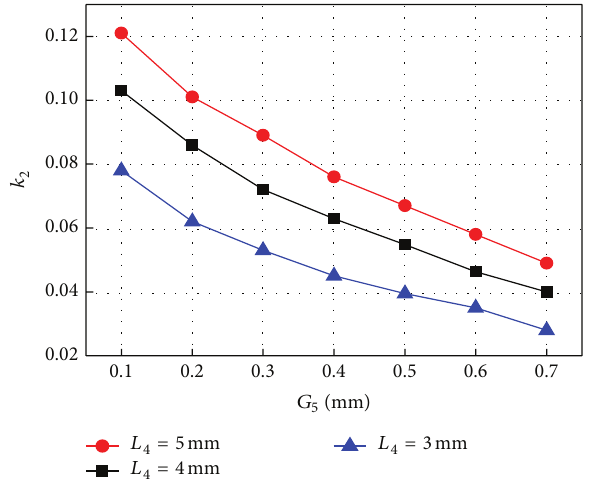
Figure 5: 𝑘 2 against 𝐺 5 and 𝐿 4